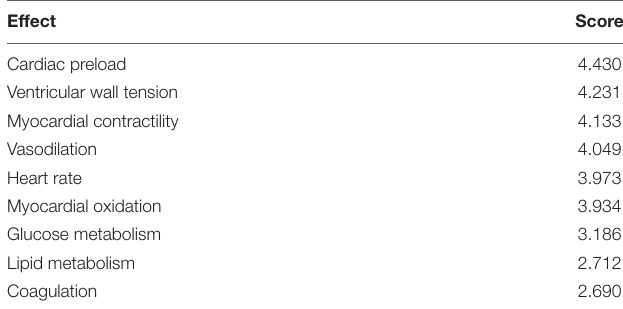
TABLE 2 | Predicted score of effects based on the Schisandra components in the treatment of